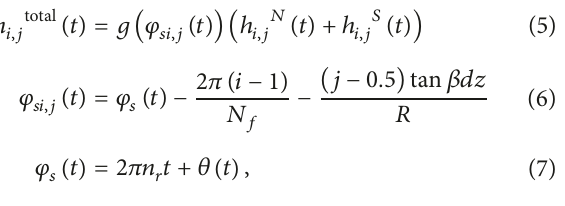
jtotal (𝑡)) 𝐾 (ℎ represent the tangential and radial milling force 𝑟 𝑖, coefficients, respectively. 𝑑𝑧 represents the axial length, and 𝑀 represents the number of elements per